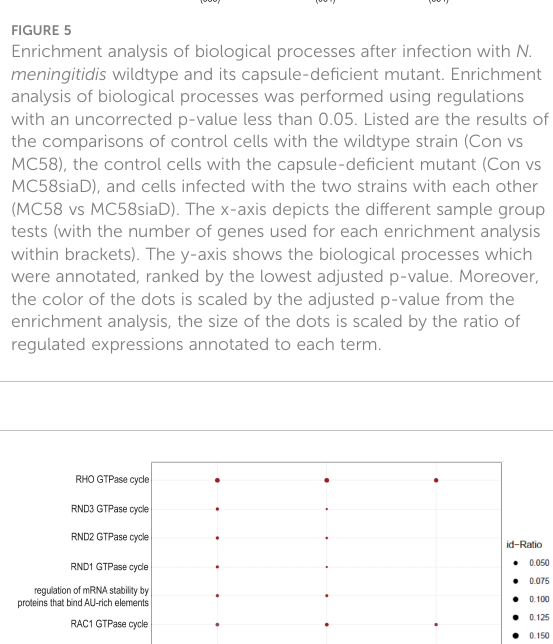
Figure 8 has been fi ltered to only include kinases with at least 5 phosphorylated sites mapped to it from the data. Overall, the kinase activity depicts more potentially regulated kinases after infection of HIBCPP cells with the N. meningitidis capsule-de fi cient mutant than after infection the with N.